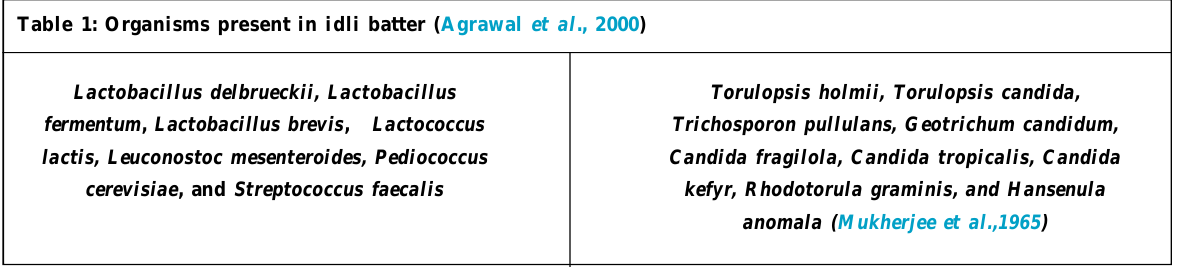
Torulopsis holmii, Torulopsis candida, Trichosporon pullulans, Geotrichum candidum, Candida fragilola, Candida tropicalis, Candida kefyr, Rhodotorula graminis, and Hansenula anomala (Mukherjee et